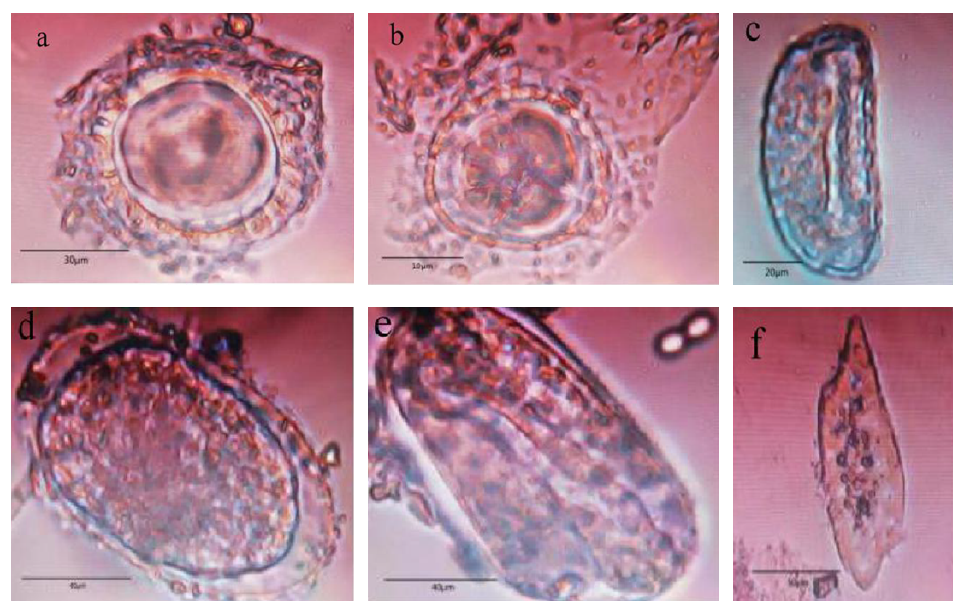
Figure 2. Gastrointestinal parasite presents in fecal samples of macaques. ( a ) Ascaris eggs; ( b ) trem ‐ atoda eggs; ( c ) enterobius eggs; ( d ) physaloptera eggs; ( e ) ancylostoma duodenale eggs spp.; ( f ) ces ‐ toda egg .